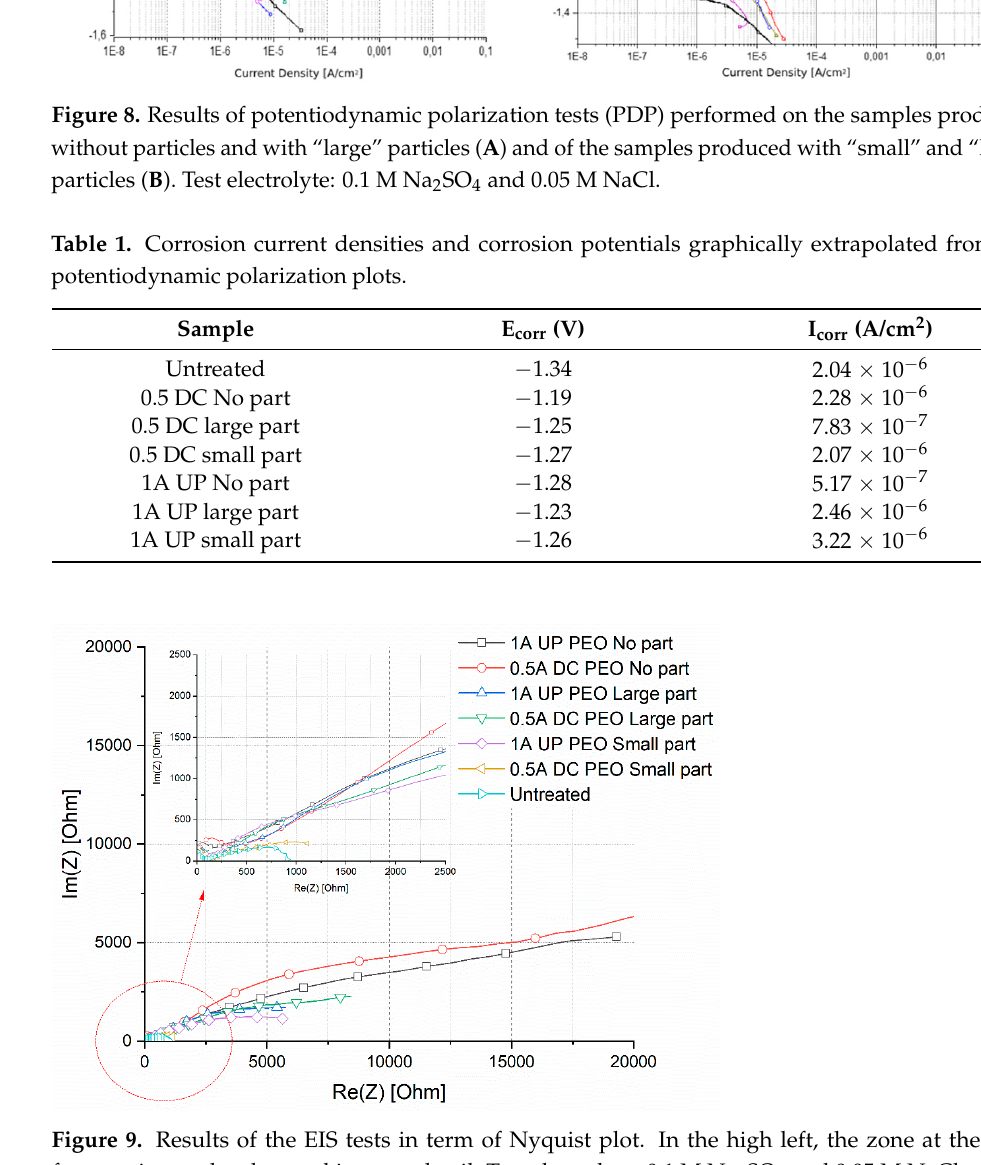
Figure 8. Results of potentiodynamic polarization tests (PDP) performed on the samples produced without particles and with “large” particles ( A ) and of the samples produced with “small” and “large” particles ( B ). Test electrolyte: 0.1 M Na 2 SO 4 and 0.05 M NaCl. Table 1. Corrosion current densities and corrosion potentials graphically extrapolated from the po- tentiodynamic polarization plots.